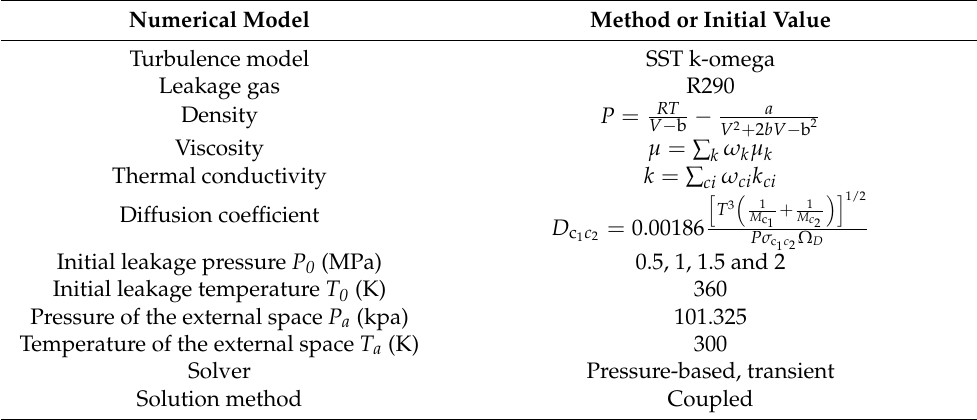
Figure 4. Computational meshes of fluid area: ( a ) mesh in the external space; ( b ) mesh in the pipeline and leakage section; ( c ) mesh in the local flow area in space below the leak hole; ( d ) mesh in the XY section. Table 3. The solution method or initial value of the parameters in the numerical model [34,35].